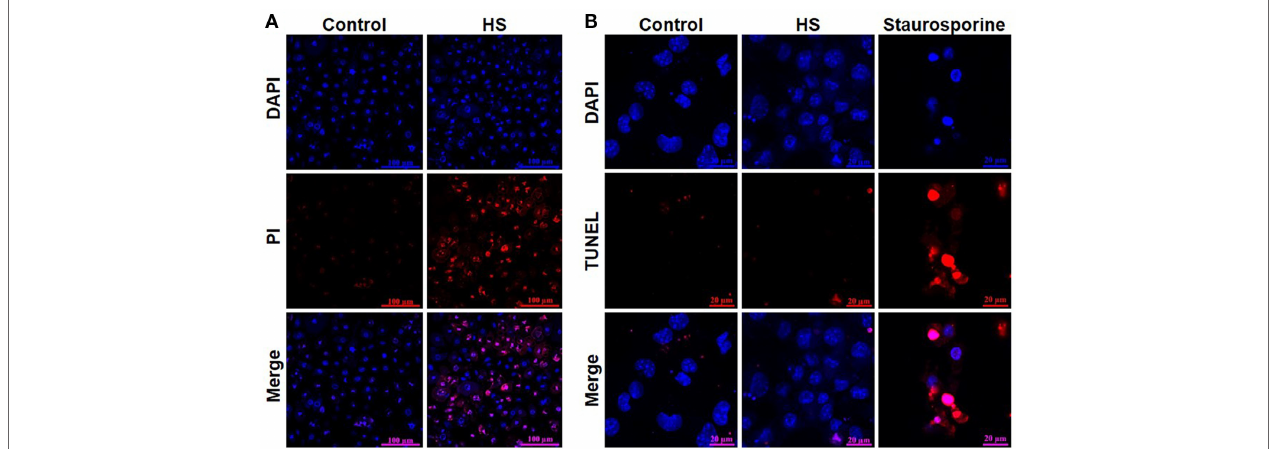
FIGURE 3 | Heparan sulfate induces cell death but no apoptosis in cardiomyocytes. (A) HL-1 cardiomyocytes exposed to 10 μ g/ml of HS for 16h were stained with Hoechst and PI and compared to unstimulated cells (control) and analyzed with confocal live-cell imaging. Hoechst represent the cell nuclei (blue) and PI the death cells (red). (B) HL-1 cardiomyocytes exposed to HS for 16h or 2.5 μ M staurosporine were stained with DAPI and TUNEL and compared to unstimulated cells. DAPI represent the cell nuclei (blue) and TUNEL the apoptotic cells (red). HS, heparan sulfate; DAPI, 4 ′ ,6-diamidino-2-phenylindole; PI, propidium iodide; TUNEL, TdT-mediated dUTP-biotin nick end